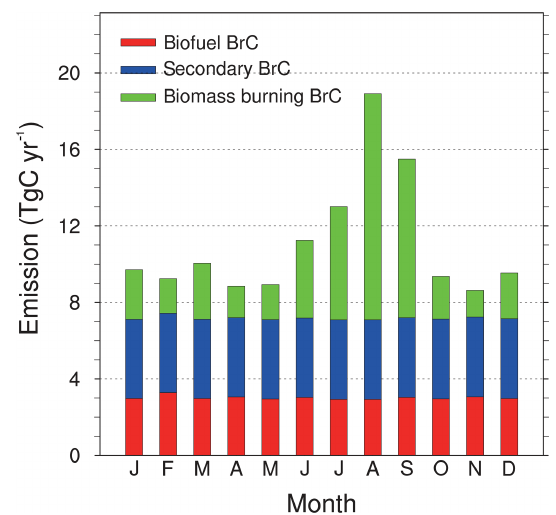
Figure 2. Monthly mean global BrC emission rates (TgCyr − 1 ) in 2010. Green, blue and red bars represent the emissions from biomass burning, biofuel combustion and secondary BrC formation,